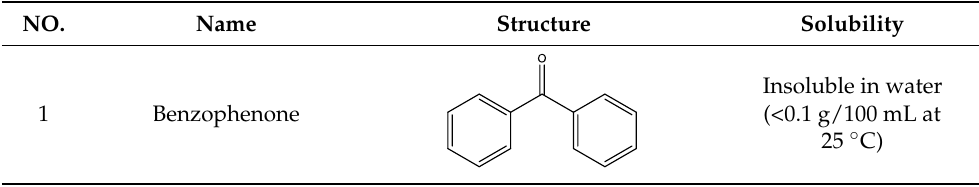
Table 1. The structure and solubility of Part BPs.